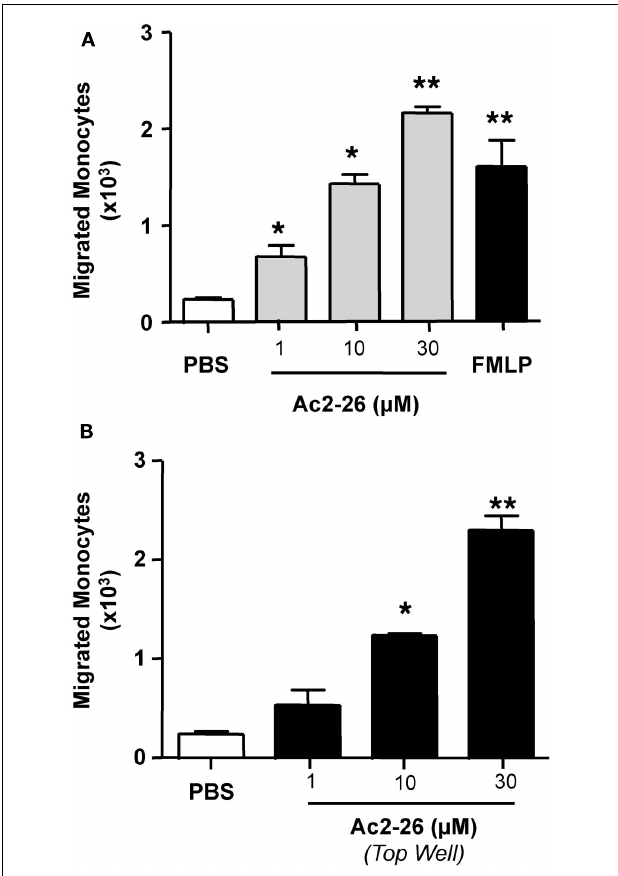
FIGURE 5 | PeptideAc2-26 induced human monocytes chemokinesis. Monocytes were isolated from peripheral blood of healthy volunteers as indicated in the Section “Materials and Methods” and resuspended at 4 × 10 6 cells/ml. (A) Chemotaxis toward peptide Ac2-26 (1–30 μ M) was evaluated after a 90-min incubation at 37˚C and 5% CO 2 . FMLP (1nM) was used as positive control. (B) Chemokinesis induced by peptide Ac2-26 was assessed by incubating the cells with the peptide prior to loading on to the top well of the ChemoTx™ plate, the number of migrated cells to the bottom chamber was evaluated after 90min incubation at 37˚C and 5% CO 2 . Results are ± SEM of three to four distinct monocyte preparations. (* P < 0.05, ** P < 0.01 vs. PBS